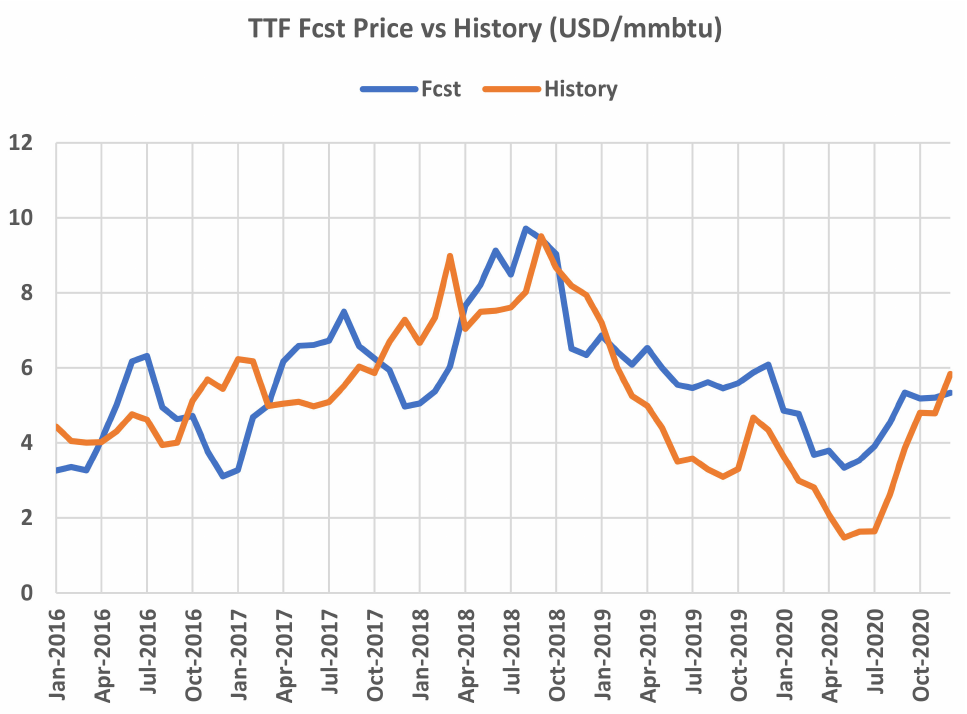
Figure 13. Calibrated gas price versus historical value for TTF.